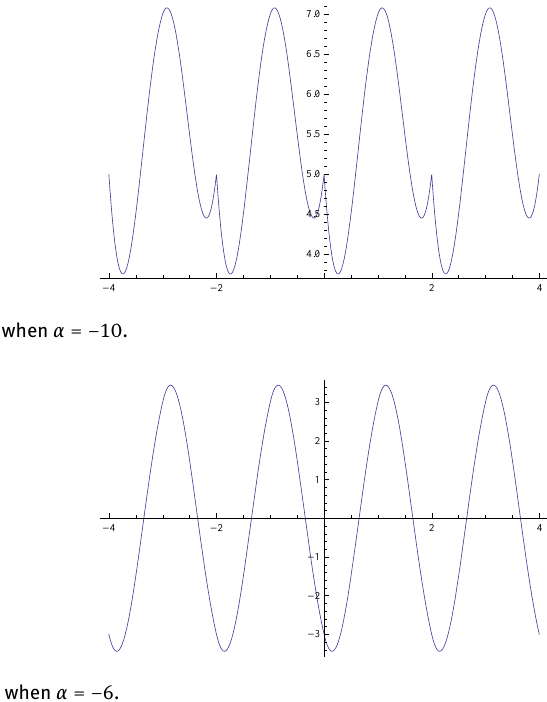
Figure 2: The graph of x ( t ) when α = −6